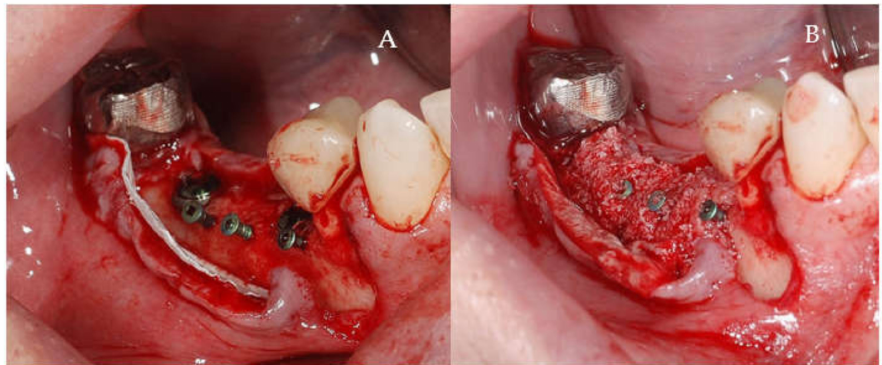
Figure 4. ( A , B ) Intra-operative clinical aspects. ( A ) Clinical aspect of the inserted implants and osteosynthesis screws. ( B ) Clinical aspect of the graft material and collagen membrane placed to delimit the future bone regeneration compartment.